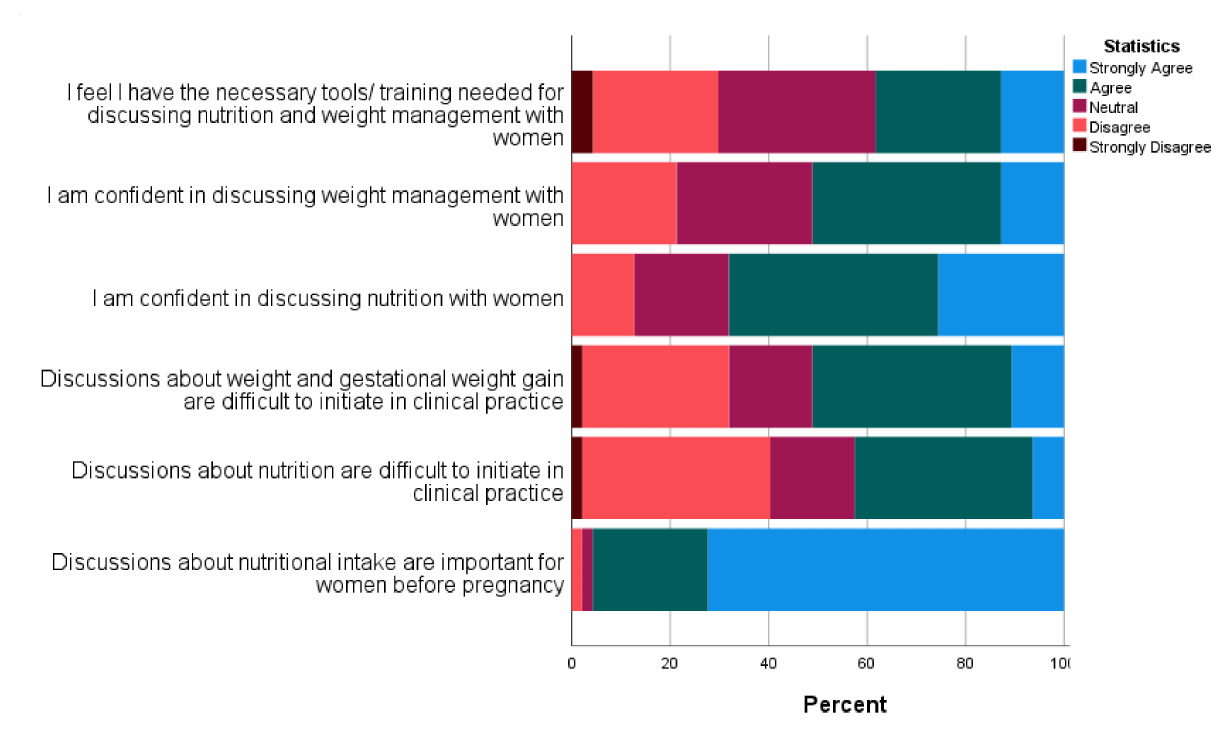
Figure 5. HCP perceptions on discussion of nutrition in routine periconceptional